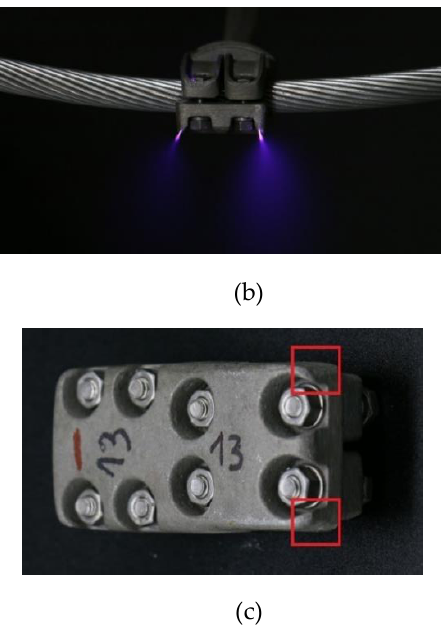
Figure 4. Visual corona tests carried out at the high-voltage laboratory. ( a ) Layout of the experimental setup. ( b ) Visual corona test performed to a J-line T-type substation connector under positive DC supply. ( c ) Identification of the areas of the connector more prone to corona activity due to the reduced curvature radius [20].